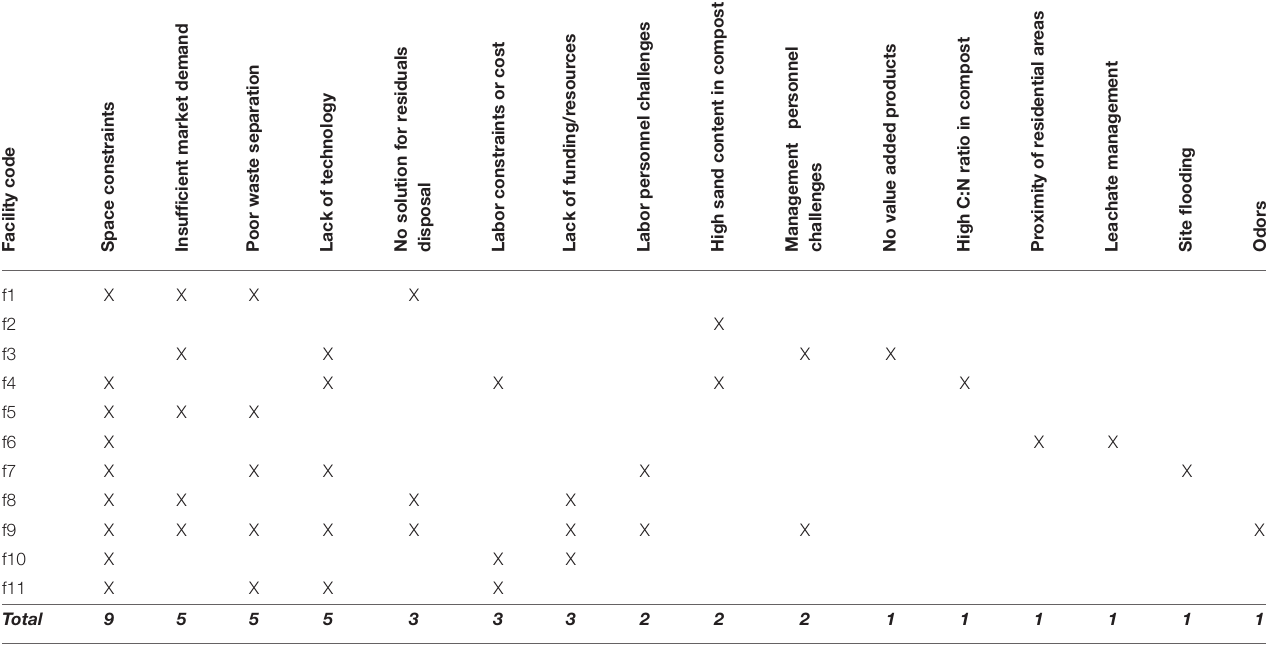
TABLE 3 | Key challenges identified by composting facility representatives in written questionnaires at the Colombo stakeholder workshop.